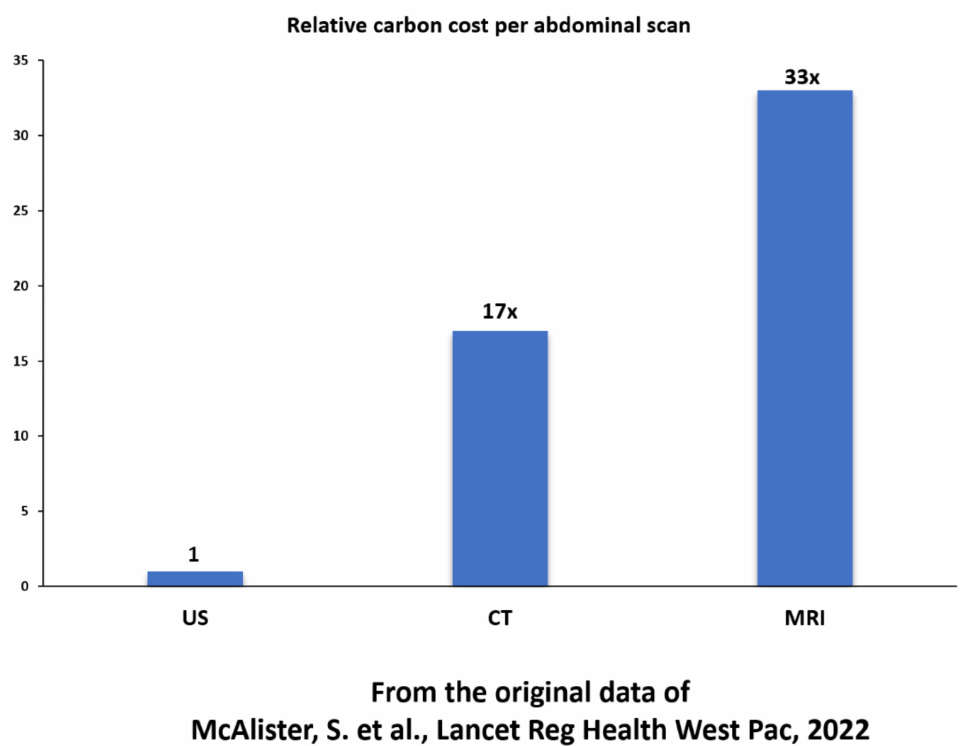
Figure 1. The relative carbon cost (CO 2 emissions/examination) for an abdominal scan with US (absolute cost 0.5 kg), CT (absolute cost 9.2 kg), and MRI (absolute cost 17.5 kg). From the original data of McAlister et al. [21].